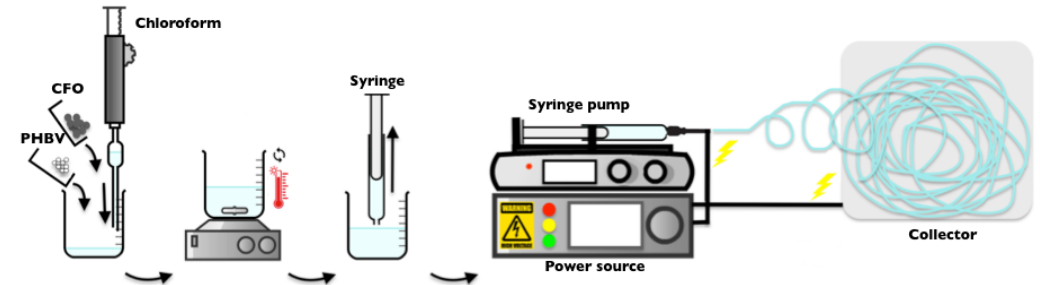
Figure 10. Schematic representation of the processing of the electrospun fibers.